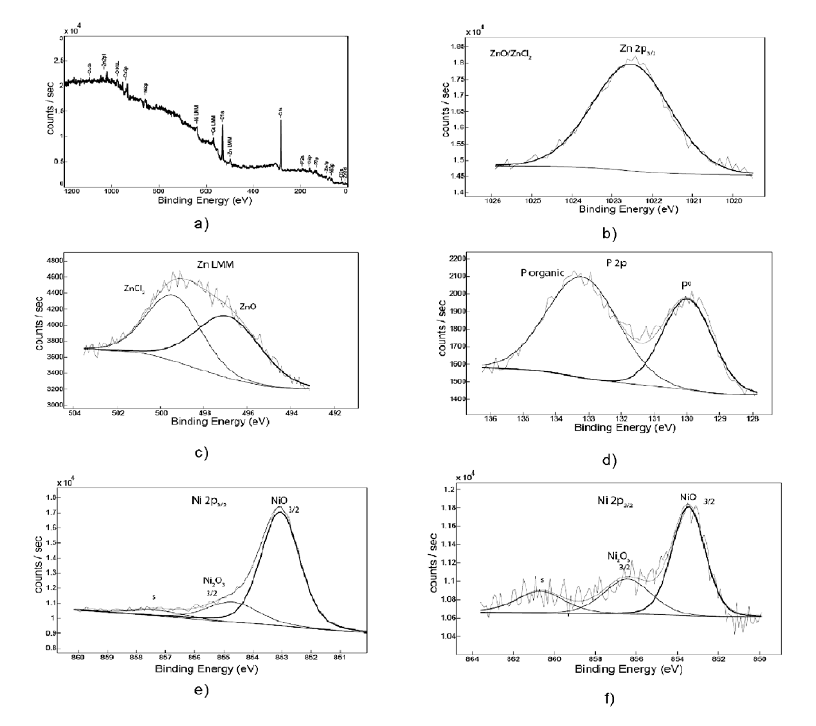
Figure 11. XPS survey spectrum for the native films on ZNP1 sample surface (a) along with the XPS narrow spectra for: Zn 2p (b), Zn LMM (c), P 2p (d), Ni in sample ZNP1 (e) and Ni in sample ZNP4 (f).